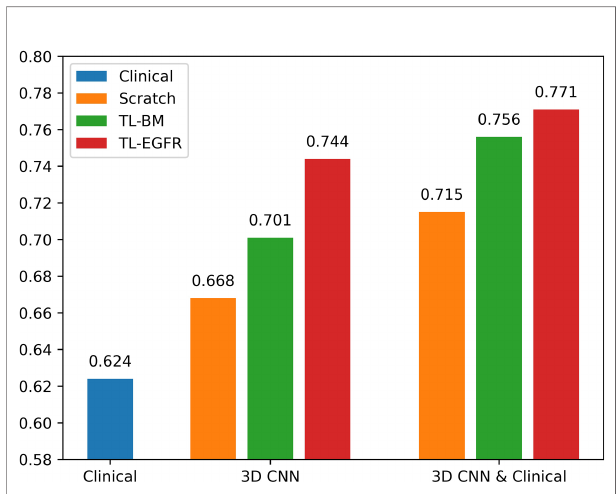
FIGURE 2 | AUCs of each PFS prediction models in the validation group. The blue ones correspond to the clinical alone model. The orange, green, and red ones correspond to CNN model trained from scratch, transferred from nodule, and transferred from EGFR classi fi cation models, receptively.